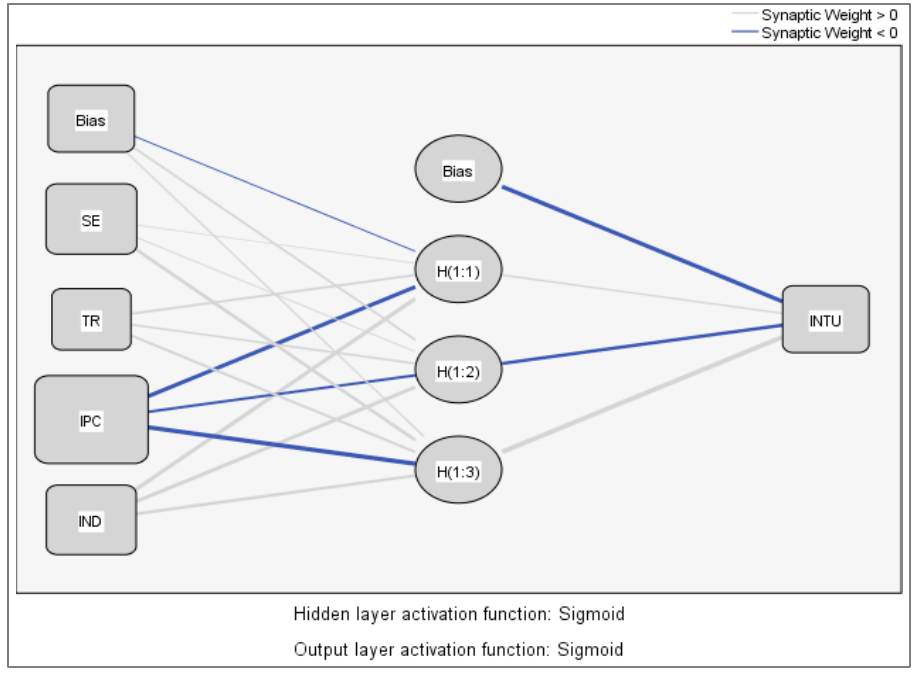
Figure 4. The ANN Model Table 5. The relationship among the predictor variables with hidden neurons must have at least one